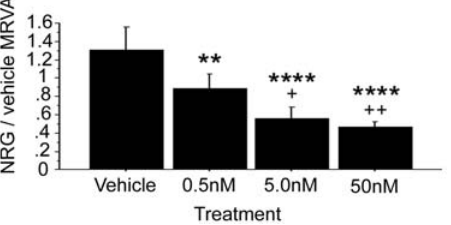
Figure 4. The phosphoinositide-3 kinase (PI3K) inhibitor wortmannin is essential for variation in NRG1 a -induced cell adhesion. Wortman- nin in DMSO vehicle (n=5) exhibited a strong, dose-dependent, dampening effect on the NRG/vehicle MRVA measure. Compared with the vehicle control, * represents p , 0.05, ** represents p , 0.01, and **** represents p , 0.0001. Compared with the low dose, + represents p , 0.05 and ++ represents p , 0.01.